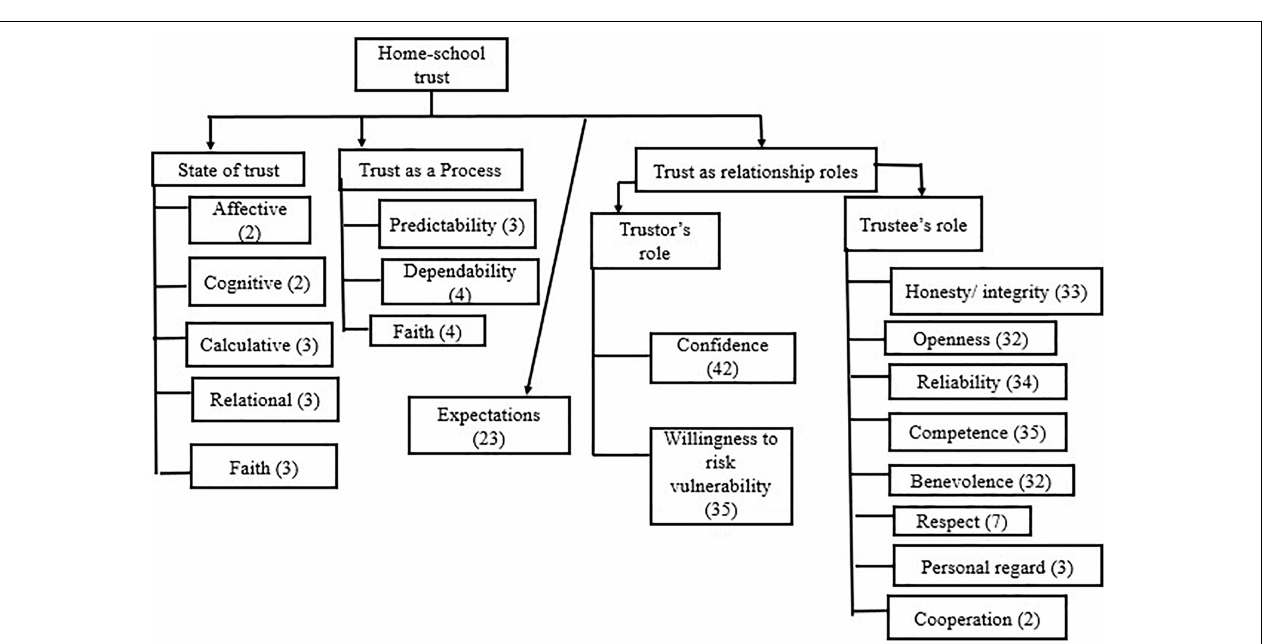
FIGURE 2 | Dimensions and elements emerged on the definition of